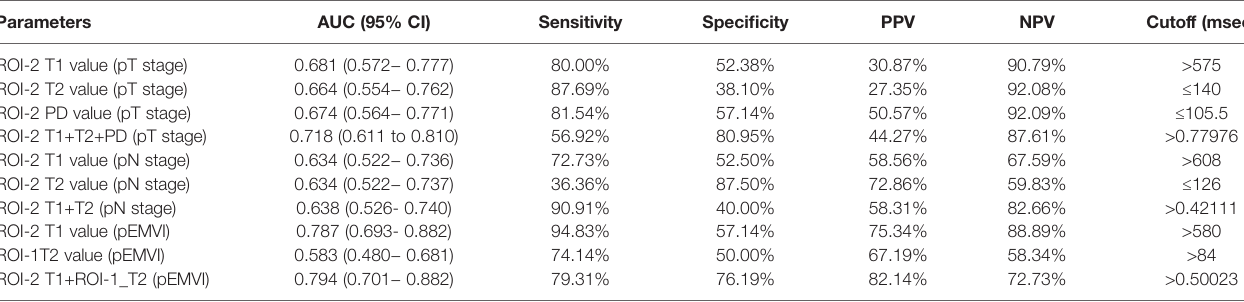
TABLE 4 | Diagnostic performance of quantitative relaxation maps in predicting T,N stage and EMVI of rectal cancer. Parameters